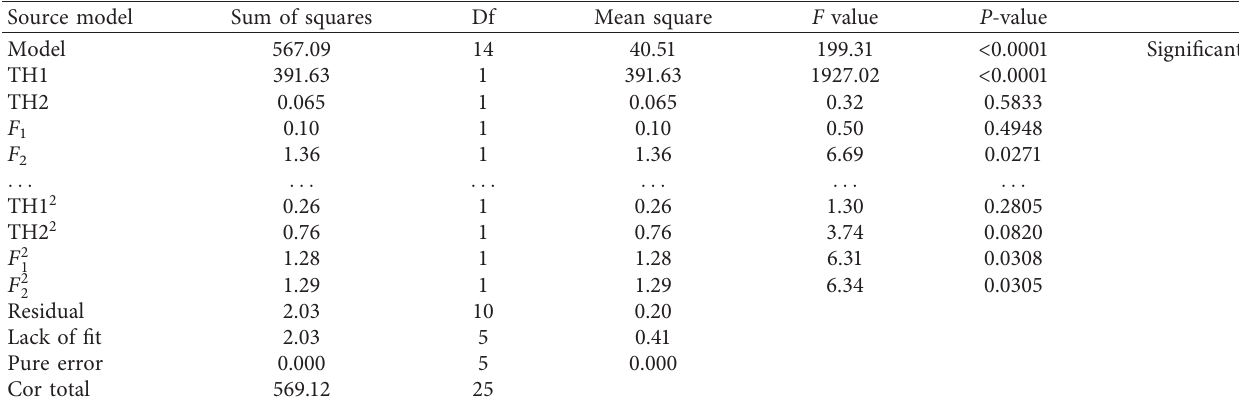
Table 4: ANOVA for response surface S 1 quadratic model.